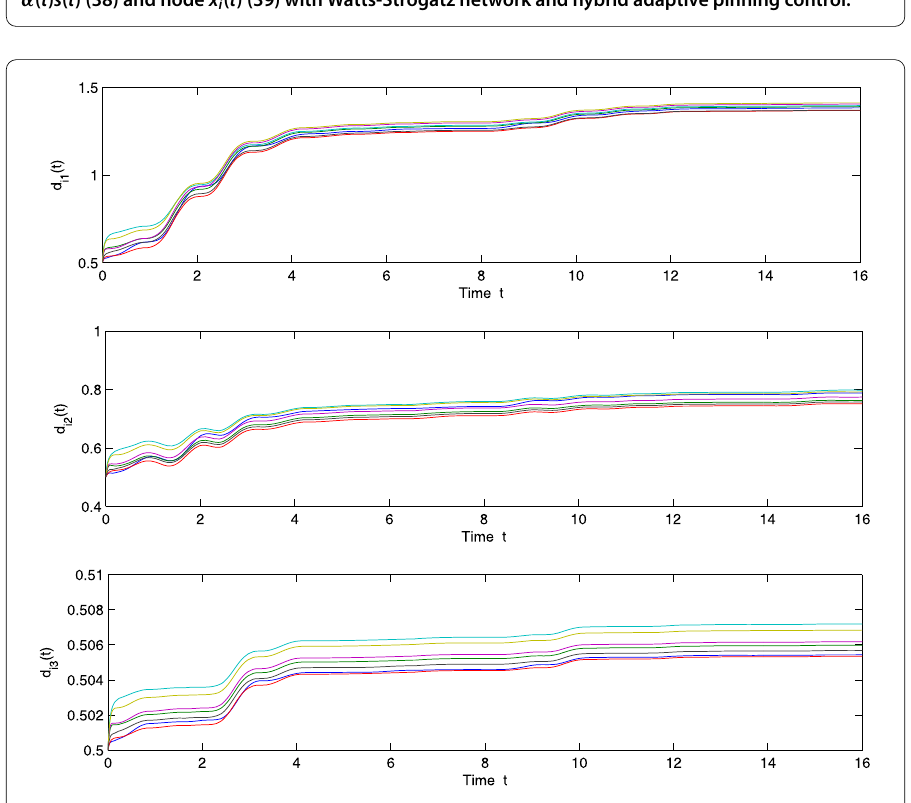
Figure 18 The evolution of adaptive pinning feedback gain d i 1 ( t ), d i 2 ( t ) and d i 3 ( t ) ( i =